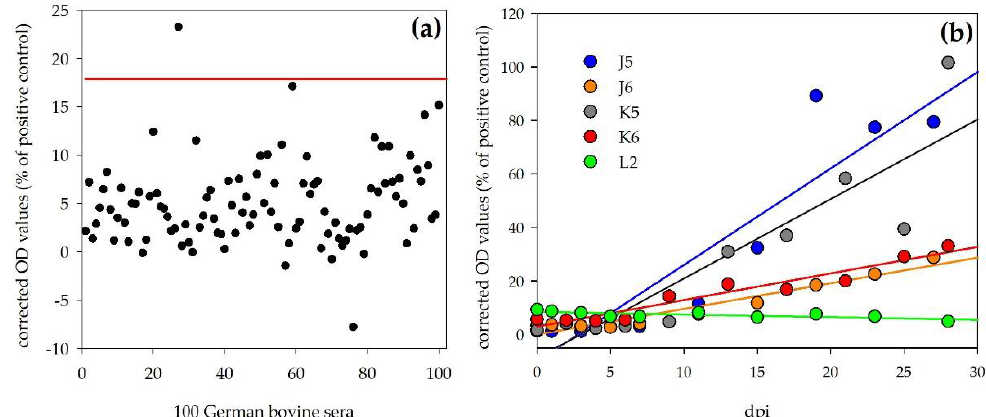
Figure 2. Bovine DUGV ELISA: ( a ) Results of 100 negative German reference sera for the determination of the negative cut-off. Diagnostic specificity for this ELISA was 99%. ( b ) Significant increase in OD values (shown by linear regression of ELISA values; calculations done by Sigmaplot) during the observation period for the four inoculated calves (J5, J6, K5, K6), whereas the OD values for the control animal (L2) stayed at the same level during the whole experiment. Table 2. Comparison of first detection of DUGV antibodies by individual assays. Challenge